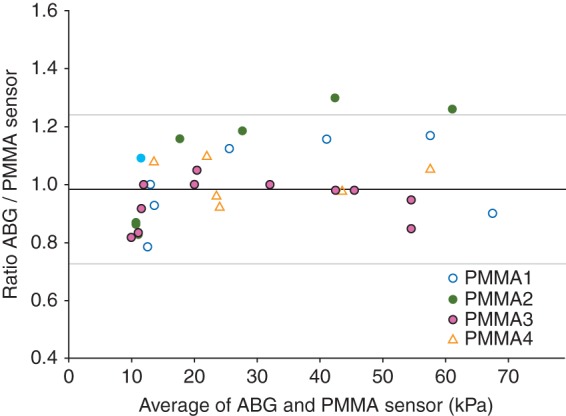
PaO2 values measured using ABG and the PMMA sensor (n=39) compared by the Bland–Altman plot; the horizontal axis is the paired average, and the vertical axis is the paired ratio (ABG/PMMA). Sensor codes are the same as in given in Figure 2. The middle solid line represents the bias (0.98), and top and bottom grey lines represent the 95% limits of agreement [mean ratio (2 sd); sd was 0.13].